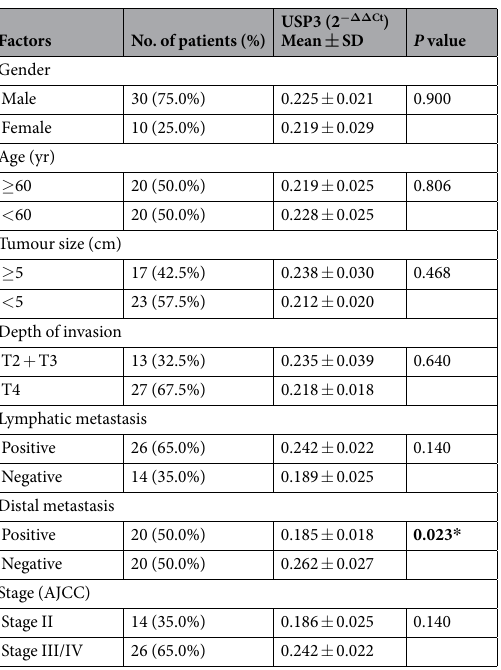
Table 1. Association between the expression of USP3 and clinicopathological features in 40 patients with CRC. * P <